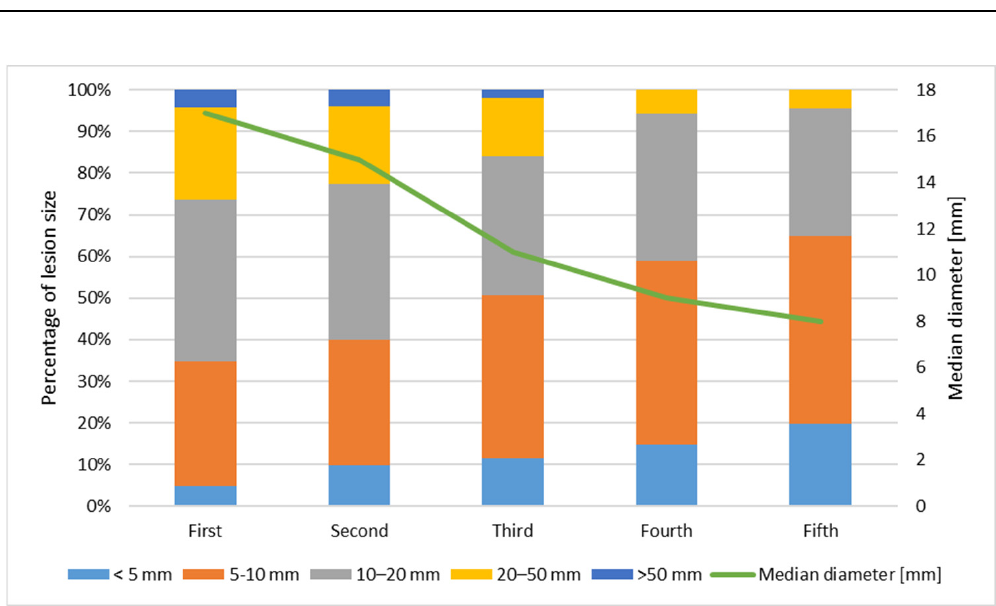
Figure 1. Size of subsequent primary KC.